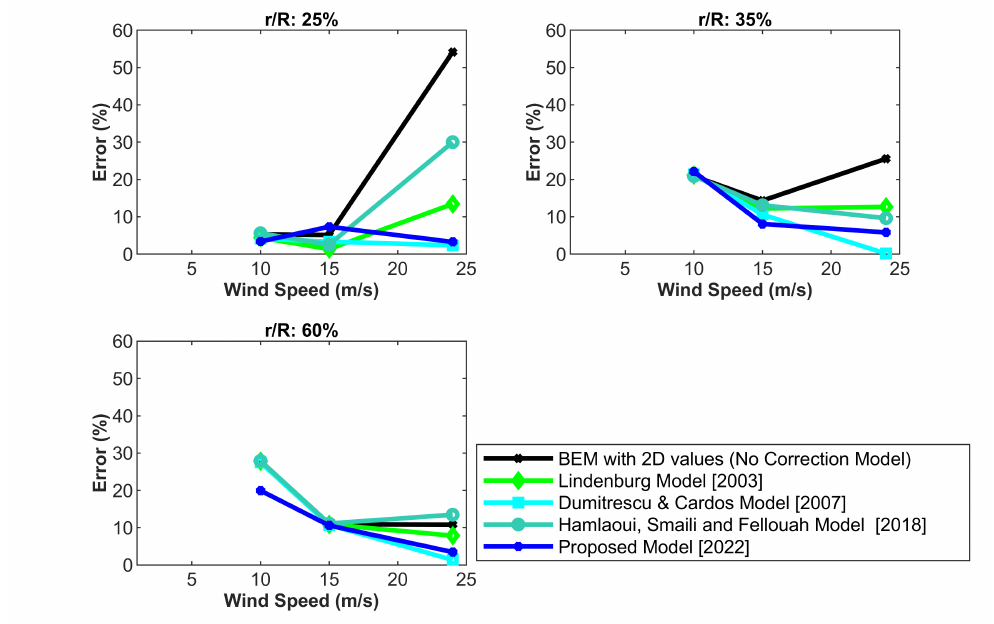
Figure 11. Error in C L computation by each model at different radial positions with different wind speeds for MEXICO